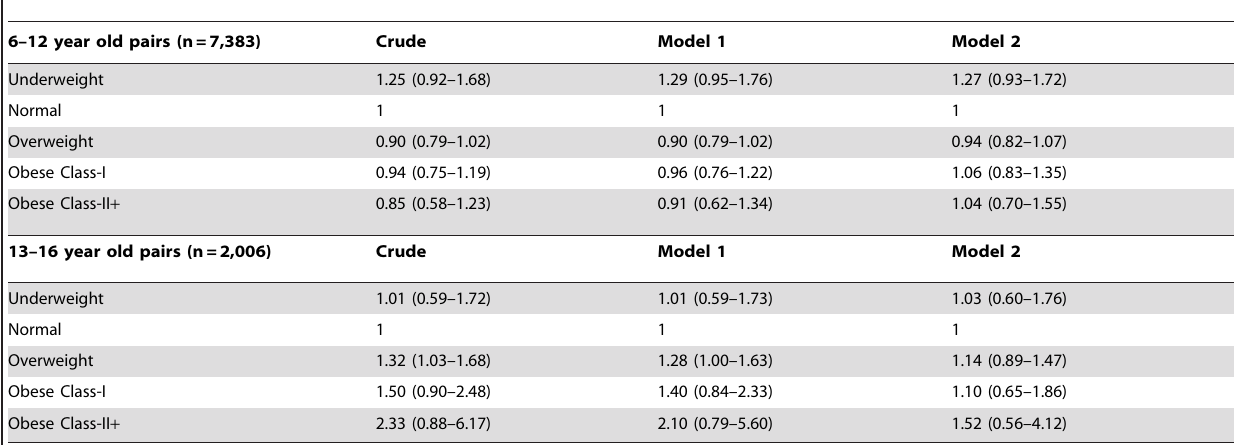
*Analysis based on a conditional logistic regression model. Model 1 – adjusted for infant gender. Model 2 – also adjusted for parity and maternal age (as continuous exposure).